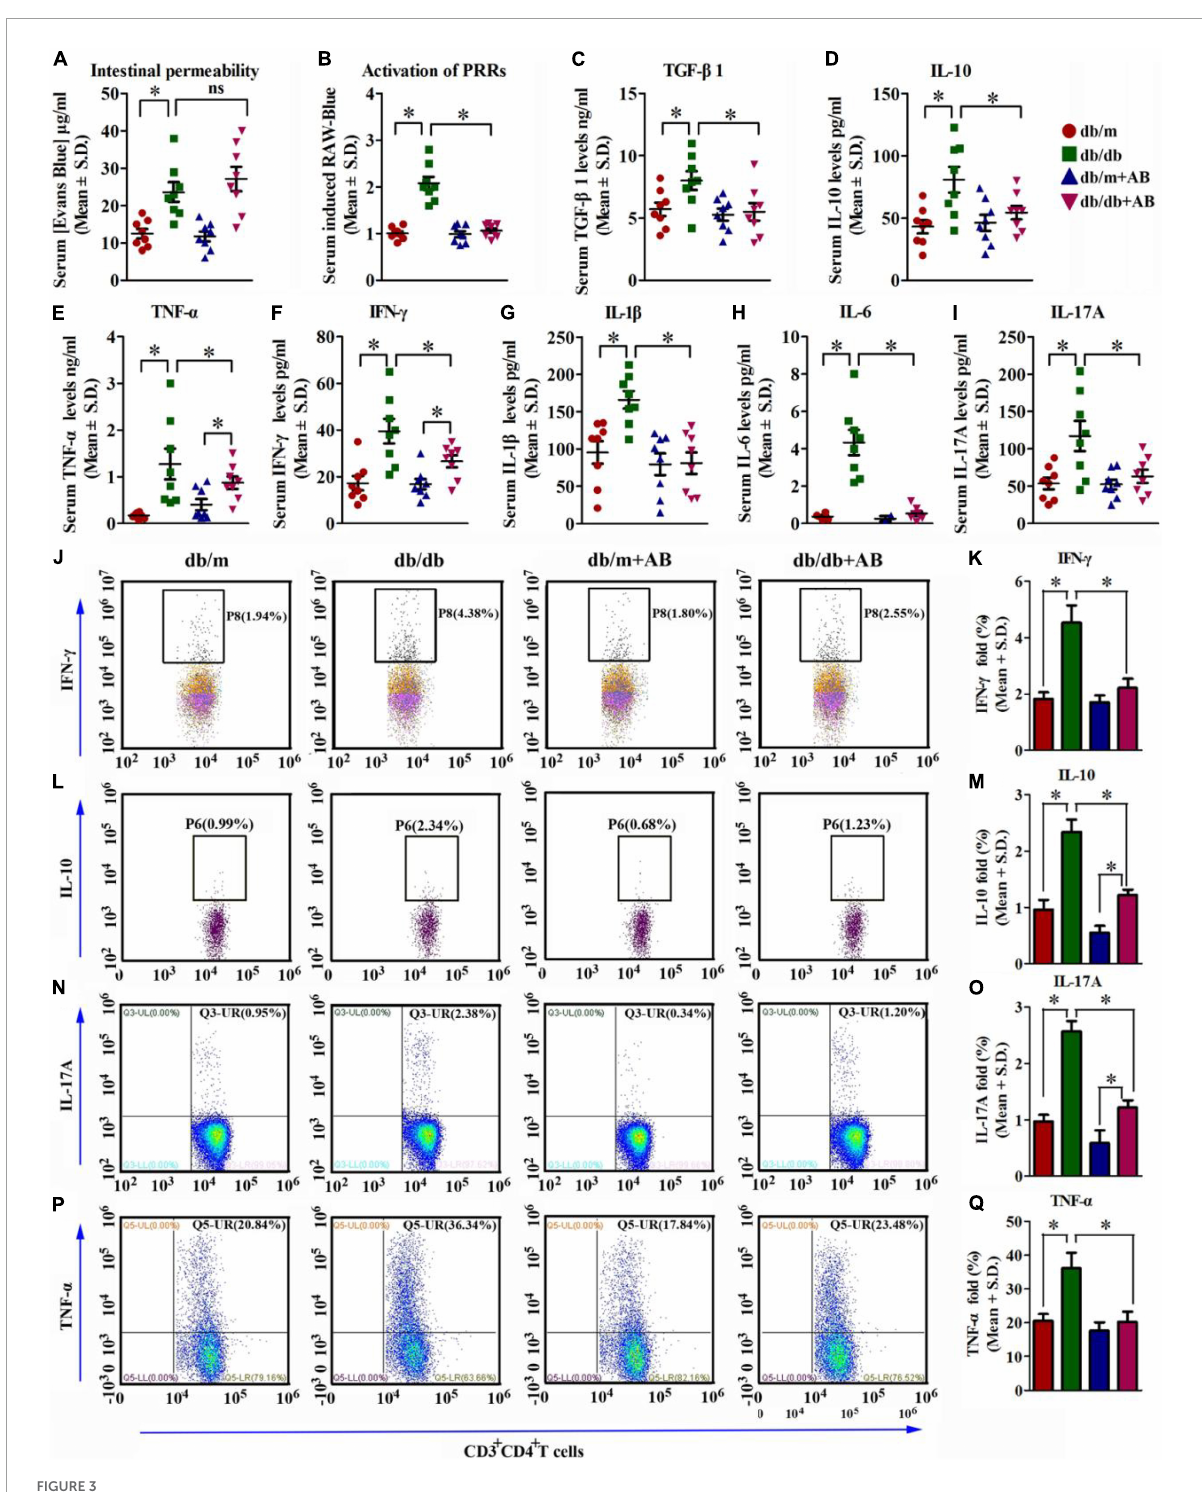
FIGURE3 Obesity augments gut permeability, metabolic endotoxemia, and systemic inflammation. (A) Concentration of gut-absorbed Evans Blue in serum 24 h after oral administration in db/db and db/m mice, treated with vehicle or with antibiotic. n = 8 in per group. ∗ P < 0.05. (B) Activation of PRRs induced by stimulation with serum isolated from db/db and db/m mice and receiving vehicle or neomycin for 3 weeks. ∗ P < 0.05. (C–I) Serum cytokine profiles determined by ELISA assay of TGF- β 1 (C) , IL-10 (D) , TNF- α (E) , IFN- γ (F) , IL-1 β (G) , IL-6 (H) , and IL-17A (I) in db/db and db/m mice, treated with vehicle or with antibiotic. n = 8 in per group. ∗ P < 0.05. (J–Q) IFN- γ (J,K) , IL-10 (L,M) , IL-17A (N,O) , and TNF- α (P,Q) levels were assayed by flow cytometry. n = 8 in per group. ∗ P <